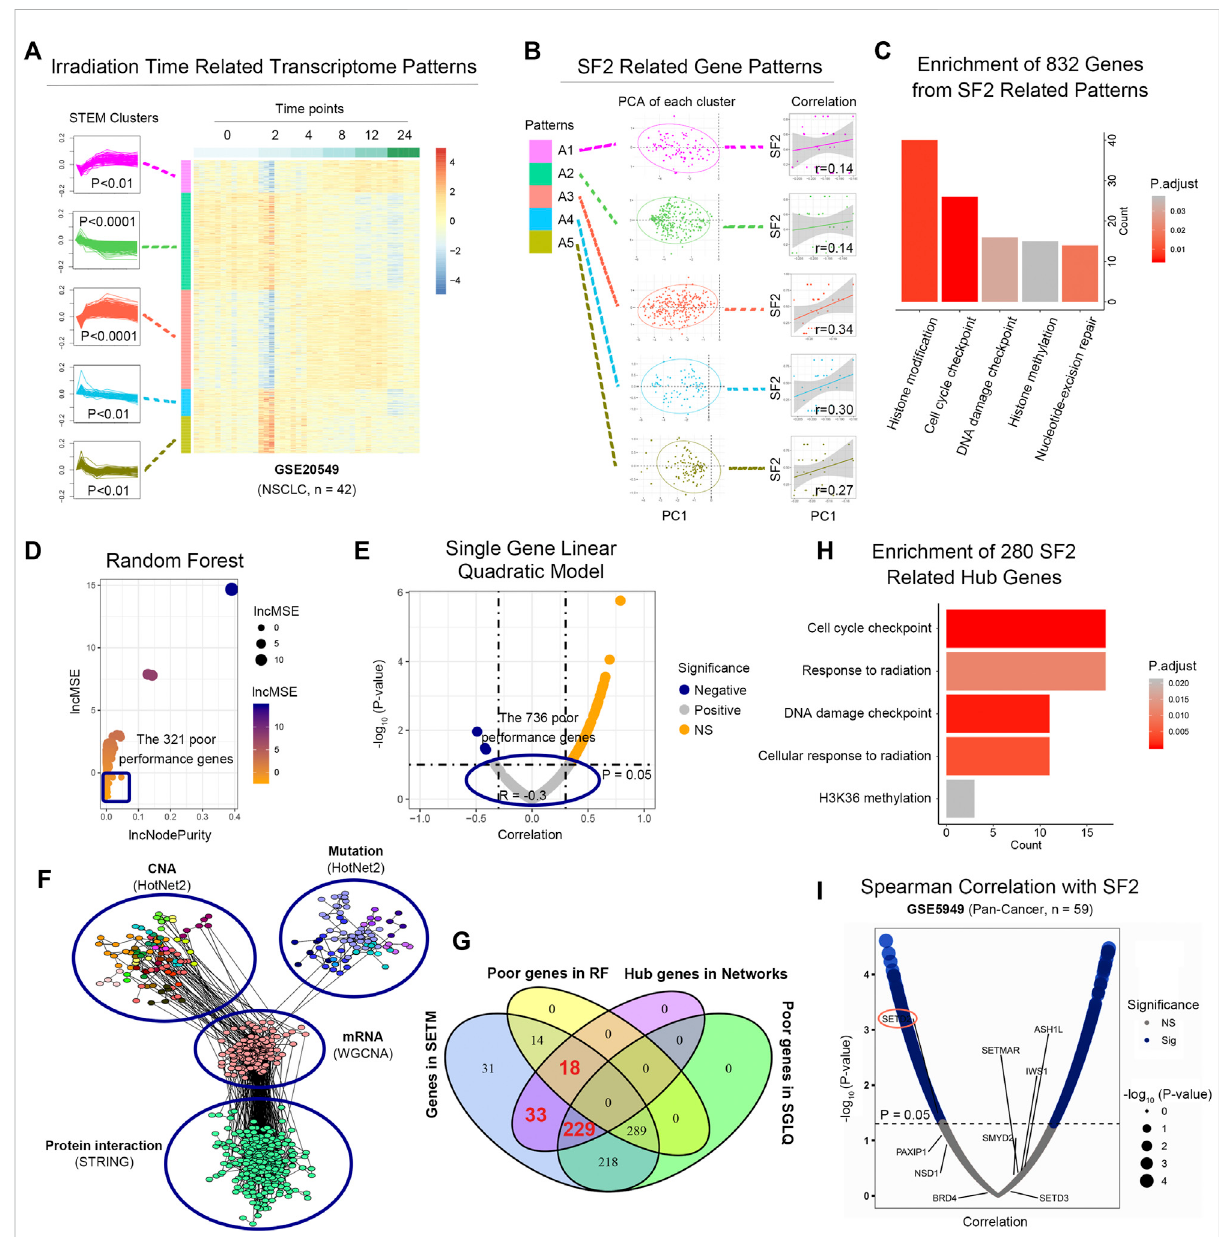
FIGURE 1 SETD2 functions as a radiosensitivity signature. (A) Radiosensitivity-related time-course clusters by the short time-series expression miner method. (B) Correlation between SF2 and the fi rst principal component (PC1) of each time-course cluster. (C) GO enrichment analysis of the 832 genes in 5 SF2-related clusters. (D) RF analysis of single gene on SF2 in GSE32036 and GSE57083. (E) SGLQ analysis of single gene on SF2 in GSE32036 and GSE57083. (F) The 4-omics biological networks included mutation, CNA, mRNA co-expression, and protein interaction sub- networks. (G) Venn diagram for screening key genes. (H) GO enrichment analysis of the 280 hub genes. (I) Correlation between gene expression and